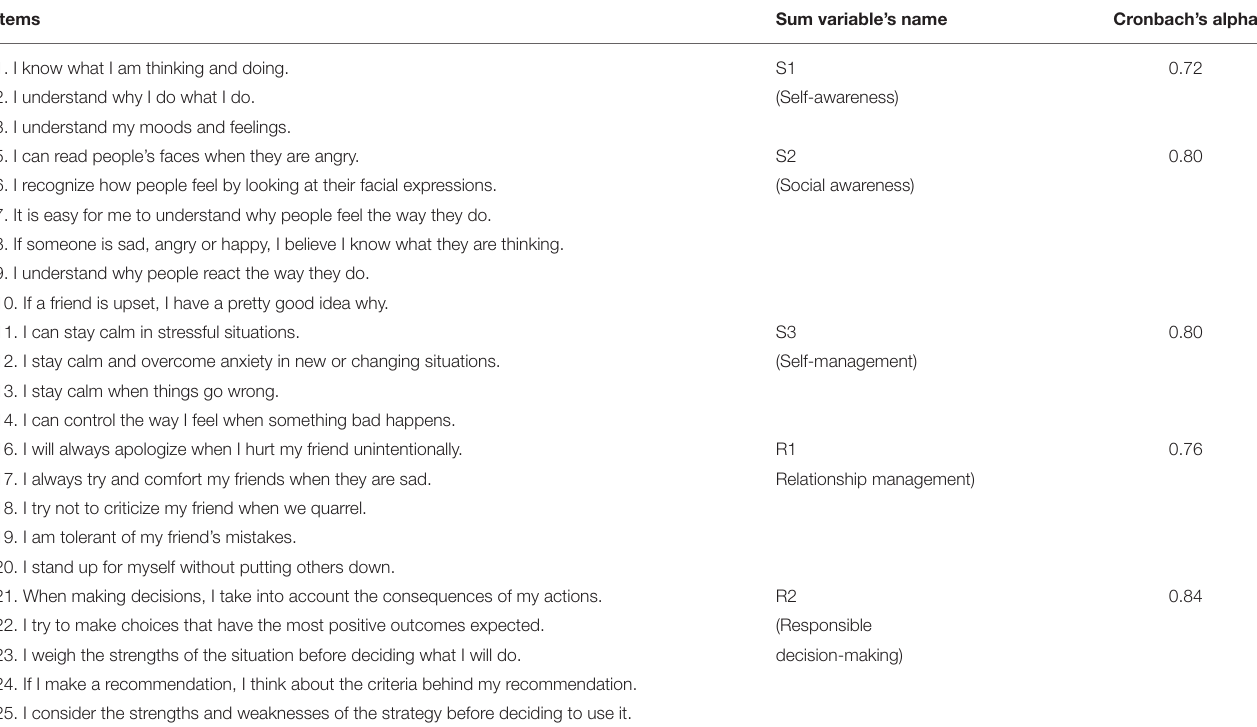
TABLE 4 | Items, variables and Cronbach’s alpha and internal consistencies of the sum variables that measure students’ social and emotional competence across all countries.